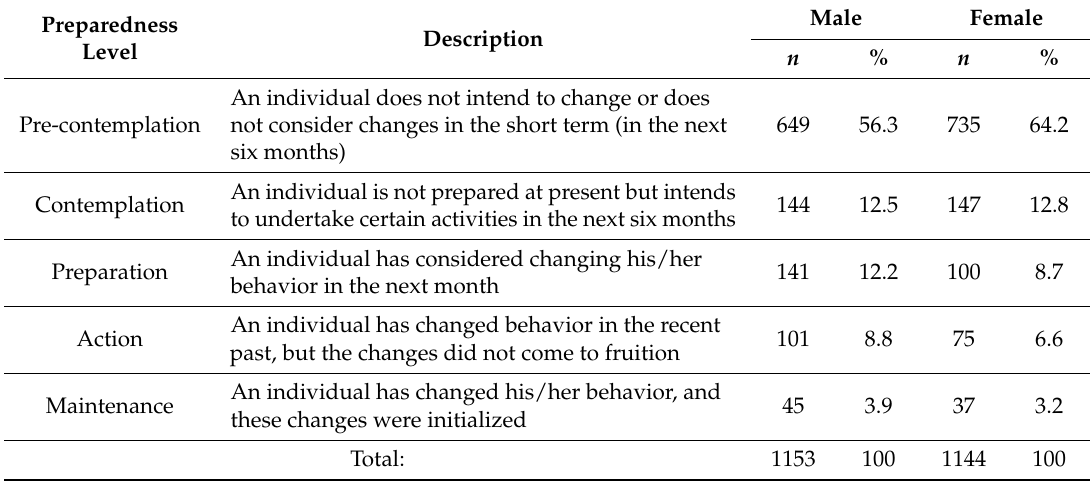
Table 6. Preparedness level from a gender perspective ( n = 2297) based on the transtheoretical model. N stands for a number of